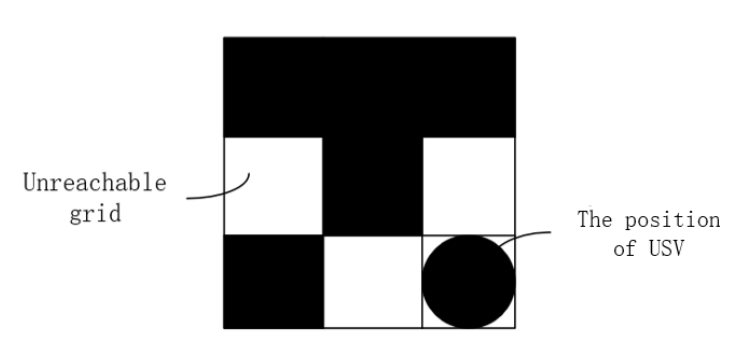
Figure 4. Unreachable